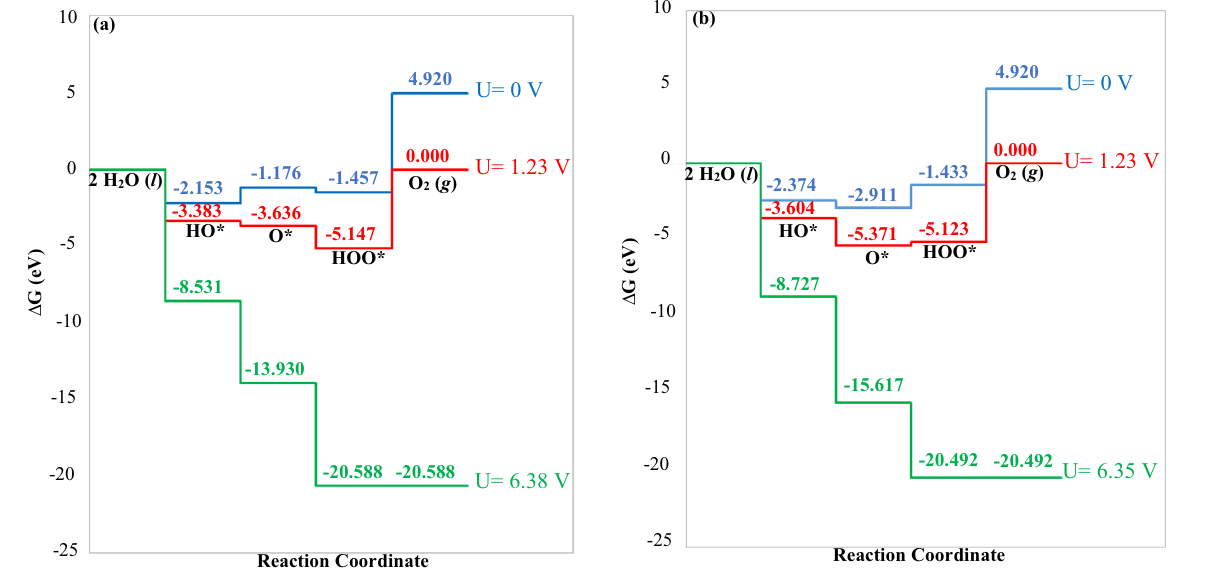
Figure 9. Free energy diagram for oxygen evolution on ( a ) ZIS and ( b )